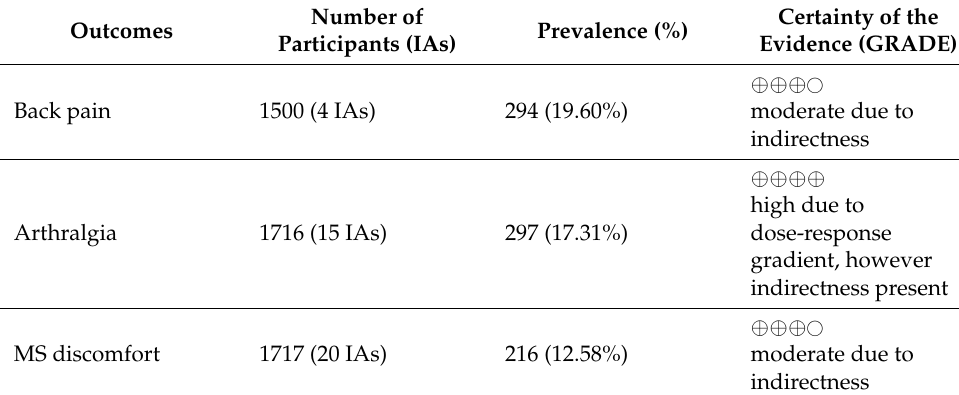
Table 8. Summary of ISO therapy adverse events: musculoskeletal